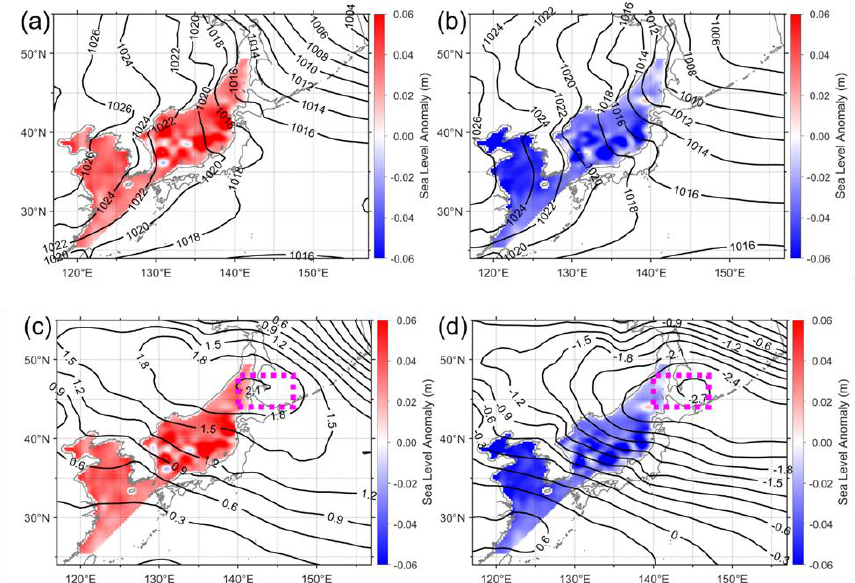
Figure 8. ( a , b ) Winter atmospheric pressure field at sea level (black contours) and ( c , d ) atmospheric pressure anomalies (black contours) during ( a , c ) Period H and ( b , d ) Period L. Here, winter NEAMS sea level anomalies are superimposed using a color scale (red: positive, blue: negative), and the area defining the NEAMS sea-level index is indicated with magenta dotted boxes ( c , d ).